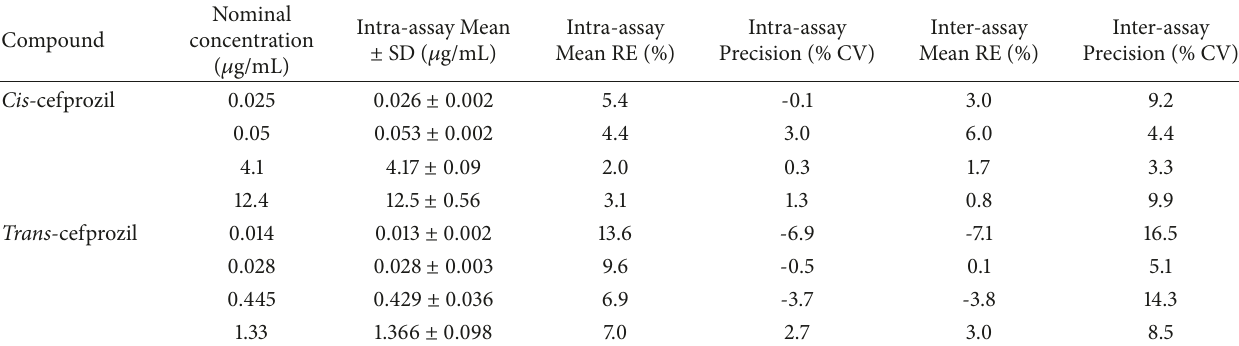
Table 1: Intra- and interassay precision and accuracy of cis - and trans -cefprozil ( n = 6). Compound